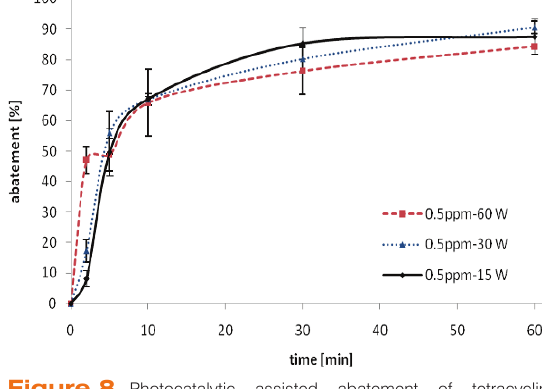
Figure 8. Photocatalytic assisted abatement of tetracycline (500 ppb) under UV-A radiation by using